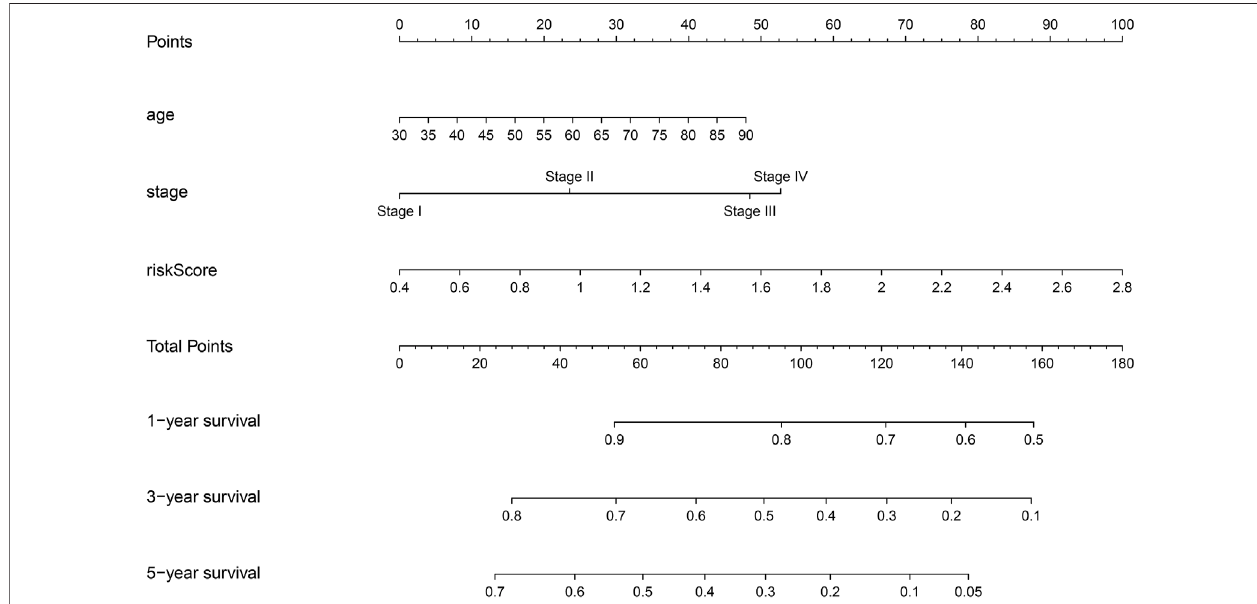
FIGURE 6 | Construction of nomogram for risk model.